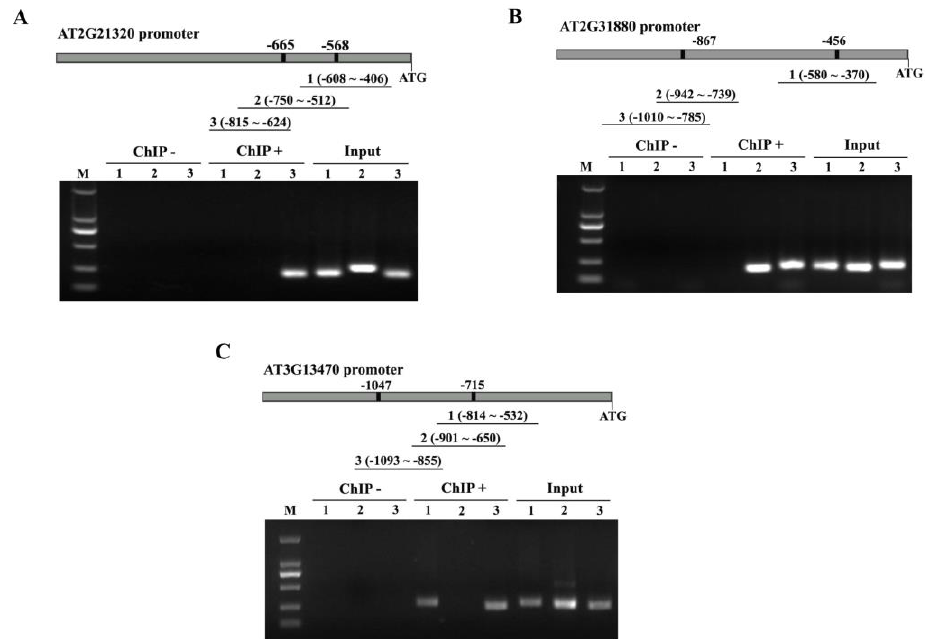
Figure 4. ChIP analysis of ANAC074 binding to NRS1, NRS2, and MybSt1. PCR products amplified from the promoters of AT2G21320 ( A ), AT2G31880 ( B ), and AT3G13470 ( C ) were size fractionated by gel electrophoresis. The promoter of AT2G21320 contains NRS1 motifs and without NRS2, Mybst1 and NACR motifs; the promoter of AT2G31880 includes NRS2 and no NRS1 and MybSt1 and NACRS; and the promoter of AT3G13470 contains only MybSt1 and no NRS1, NRS2, and NACRS. Black lines represent the promoter regions for PCR amplification, and their positions in promoters are also shown. Input, Input DNA was used as the control; CHIP+: chromatin immunoprecipitated with anti-GFP antibody and PCR amplified; CHIP-: chromatin immunoprecipitated with HA antibody and PCR amplified.